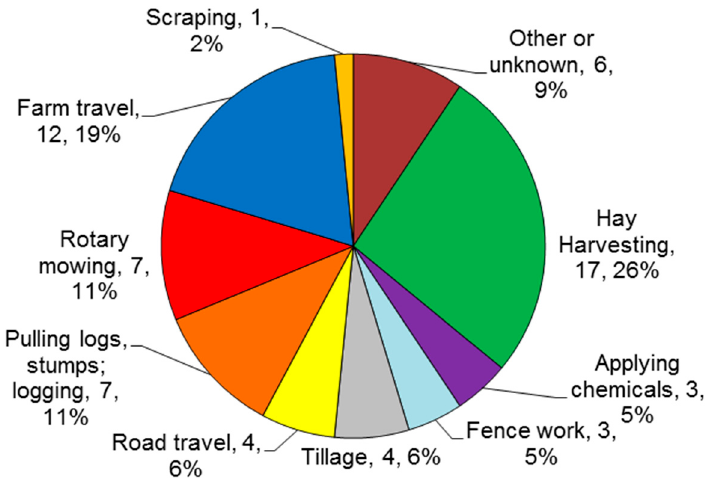
Figure 4. Chores associated with nonfatal injuries related to non-ROPS tractor overturns, n = 64. Table 5. Chore category and selected variables for overturns of non-ROPS nonfatal injuries, n = 64.